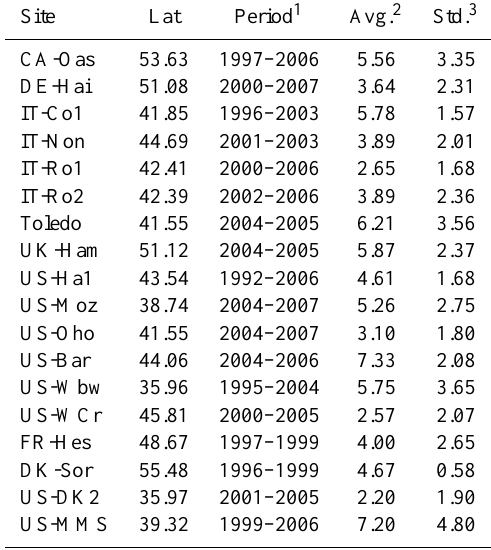
Table 2. Delayed days of soil temperature equals to mean an- nual temperature compared with air temperature in the deciduous broadleaf ecosystems (Table